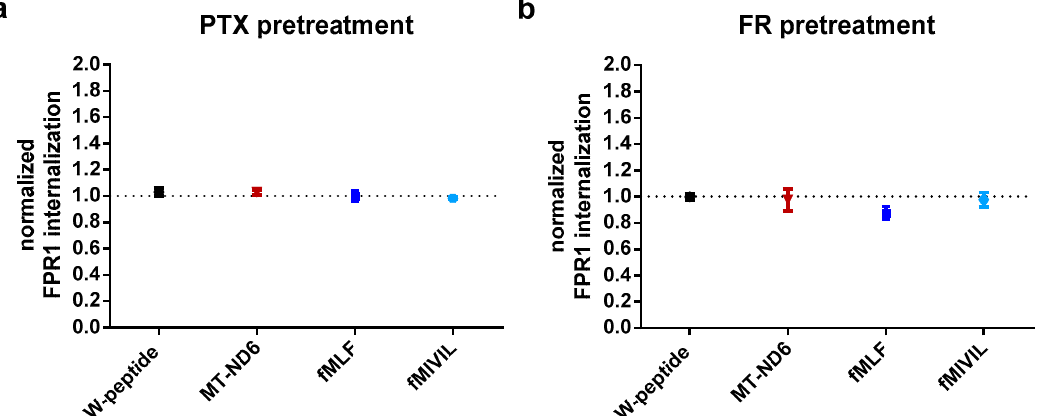
Figure 6. Agonist-induced FPR1 internalization is not dependent on G α -mediated signal transmission. ( a ) Cells were pretreated either for 16 h with PTX or ( b ) for 1 h with FR and subsequently stimulated with agonist concentrations eliciting the respective E max . Results were normalized to the 10 − 4 M W-peptide-induced maximum response. Data points represent the mean ± SEM of 6 independent measurements.